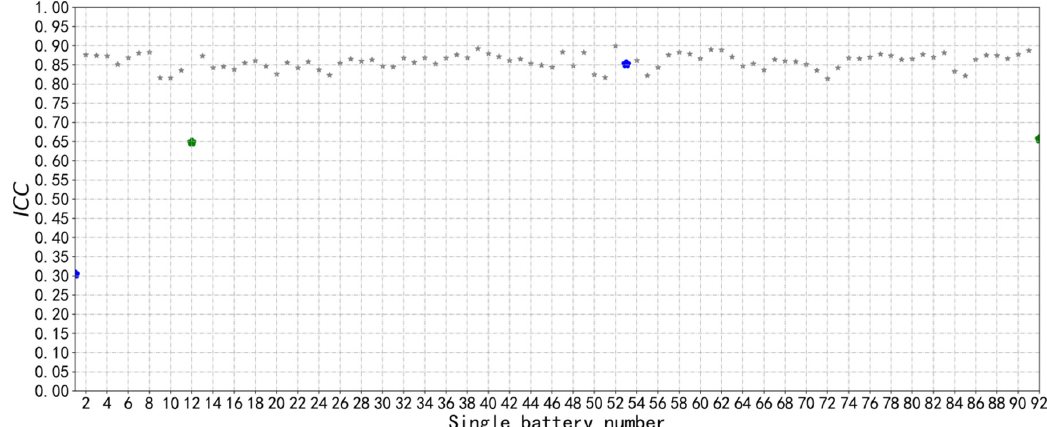
Figure 3. The ICC s of different cells’ voltages.